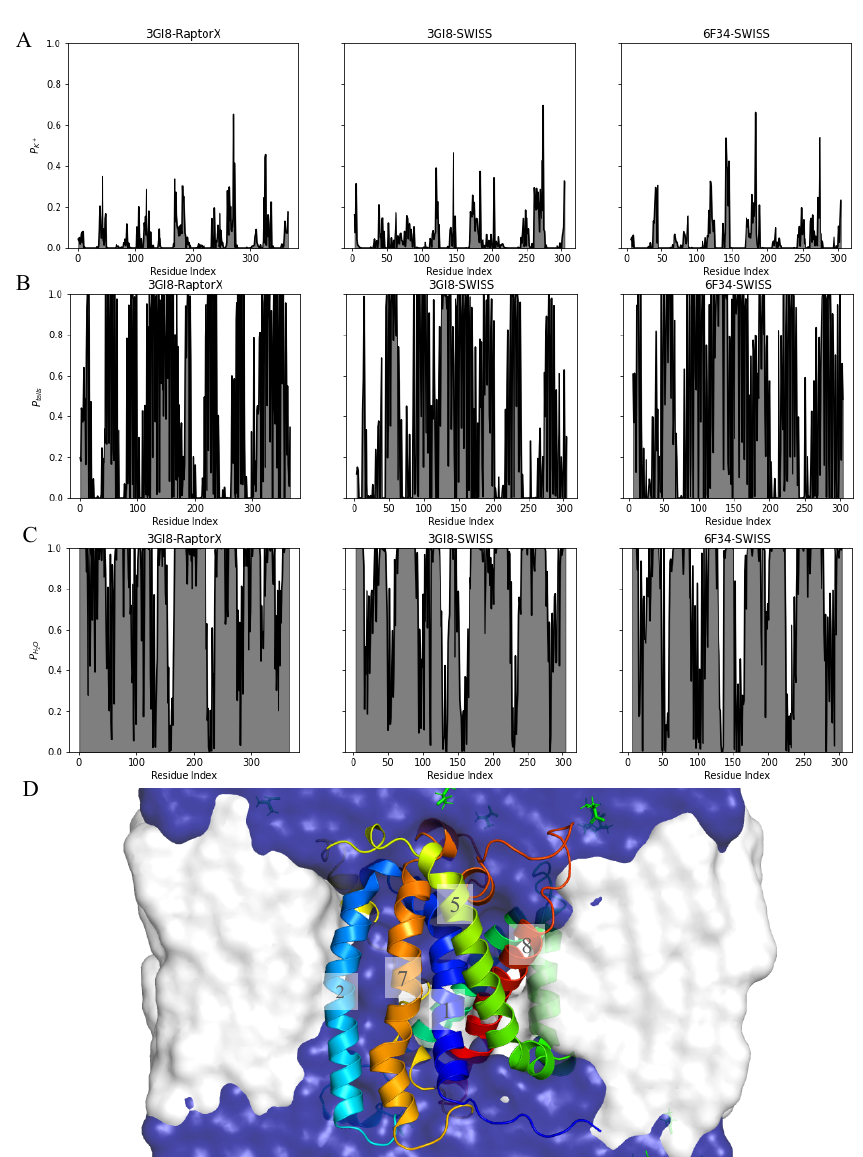
Figure 4. Interaction of GerAB residues with potassium, membrane tails and water. ( A – C ) shows the proximity plots for K + , membrane tails and water to residues of GerAB. A P value of 1 indicates that water or membrane tails are within 0.6 nm of the residue for the duration of the simulation, while a value of 0 indicates that water or lipid tails are never within a distance of 0.6 nm of the residue. The proximity is calculated over 5 runs for each model. ( D ) shows a snapshot of the complex with the membrane in white, water in blue and GerAB helices in color, corresponding to Figure 2.